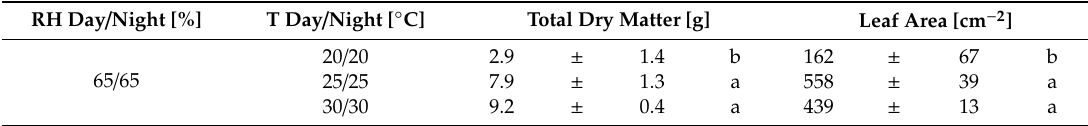
Table 3. Total plant dry matter and plant leaf area at 49 days after sowing after two weeks exposure to di ff erent constant day and night temperatures at 65% RH. Mean values of three replications are presented including standard errors. Small letters indicate di ff erences at p < 0.05 between temperature treatments. RH Day / Night [%] T Day / Night [ ◦ C] Total Dry Matter [g]